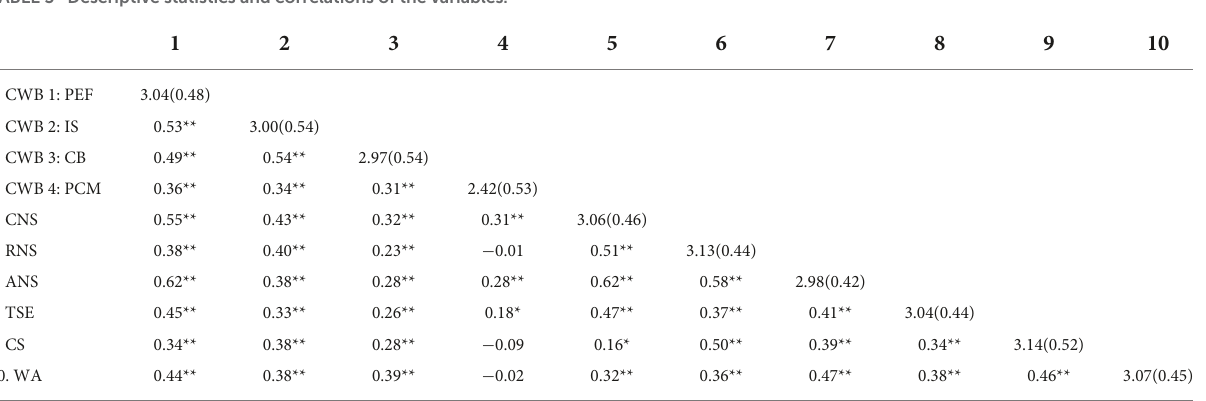
TABLE 3 Descriptive statistics and correlations of the variables.